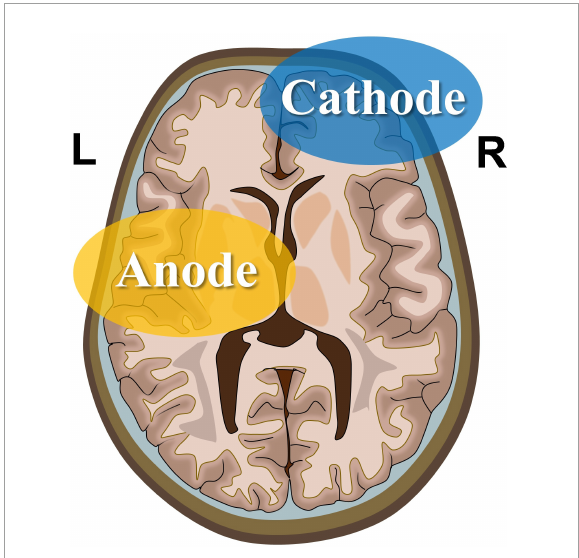
FIGURE1 Transcranial direct current stimulation montage. Saline-soaked anodal sponge electrodes (5 cm × 5 cm) are applied over the left M1 region, and a larger cathodal electrode (5 cm × 7 cm) is placed on the right supraorbital